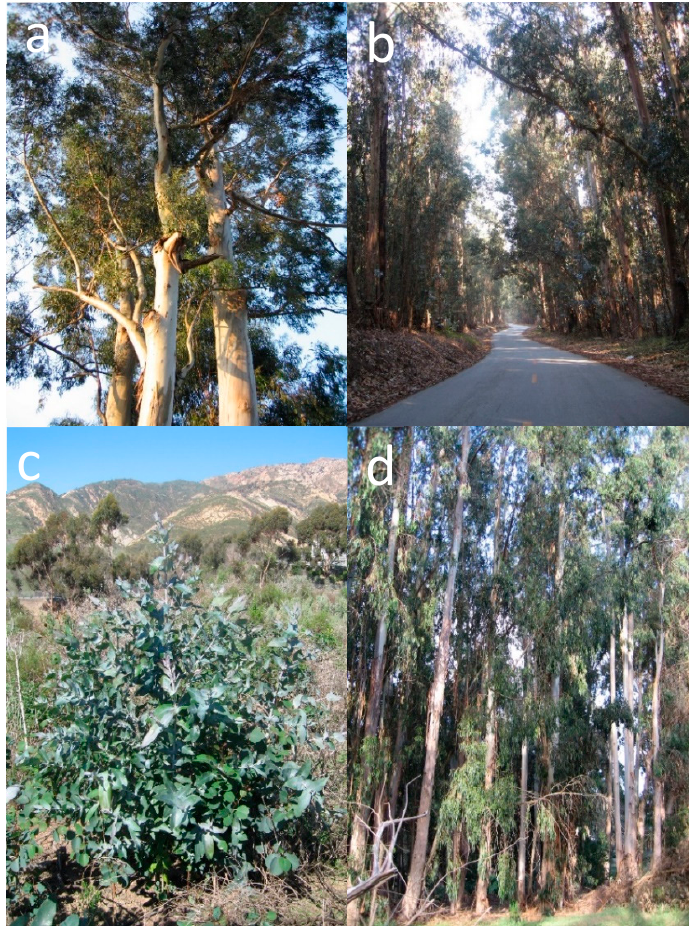
Figure 1. Eucalyptus globulus in California. ( a ) Tree canopies of old mature trees that show no sign of reproduction in San Luis Obispo County, ( b ) abandoned plantation with naturalized saplings in San Benito County, ( c ) juvenile wildlings in Santa Barbara County and ( d ) mature wildlings in Santa Cruz County.